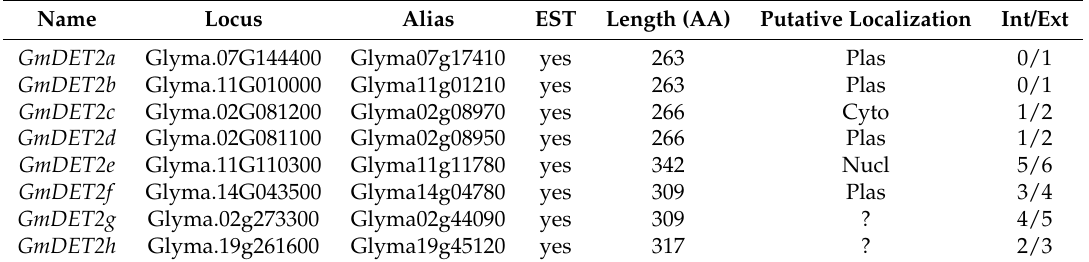
Table 1. General information about the steroid reductases in soybean based on bioinformatics